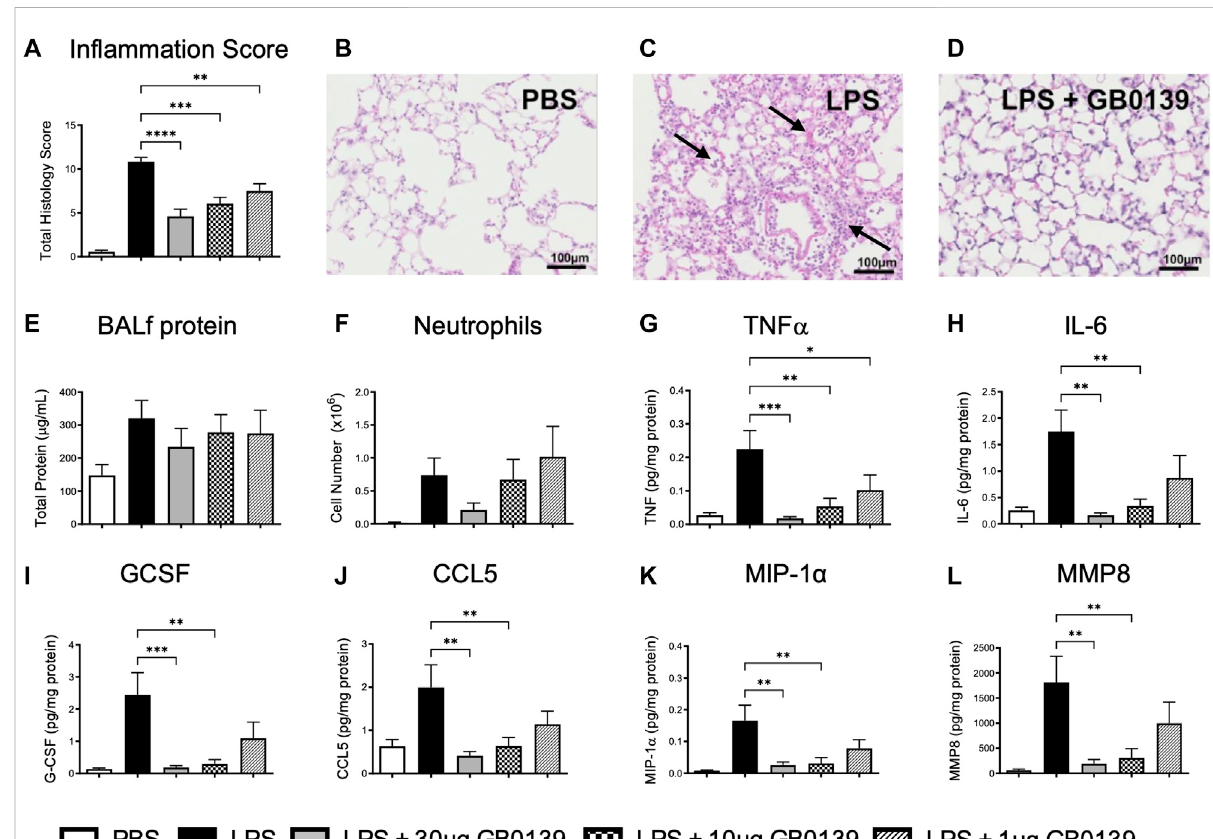
FIGURE 2 Histological and BALf analysis following LPS-induced lung in fl ammation. 10 µg LPS was administered alongside 1, 10 or 30 μ g GB0139 i.t. and tissueretrieved24 hlater.CytokinelevelswerenormalisedagainsttotalBALfprotein. (A – D) Histologyin fl ammationscoreandrepresentativeimages of H and E stained lung tissue sections. Arrows indicate areas of pulmonary in fl ammation (alveolar membrane thickening, capillary congestion and alveolar neutrophil in fi ltration). In fl ammation score was based on the presence of alveolar membrane thickening, capillary congestion, intra- alveolar haemorrhage, interstitial neutrophil in fi ltration and alveolar neutrophil in fi ltration. (E) BALf total protein. (F) BALf neutrophil numbers. (G – J) BALfpro-in fl ammatorycytokinepro fi les. (K – L) BALfpro- fi broticcytokinepro fi les.Datarepresentedasmean±SEM.Analysedvia1-wayANOVA(n= 6, * p < 0.05, ** p < 0.01, *** p < 0.001, **** p < 0.0001). Images taken at ×200 magni fi cation. ANOVA = analysis of variance; BALf = broncho-alveolar lavage fl uid; CCL = C-C motif chemokine ligand; E = eosin; G-CSF = granulocyte-colony stimulating factor; H = hematoxylin; h = hours; IL